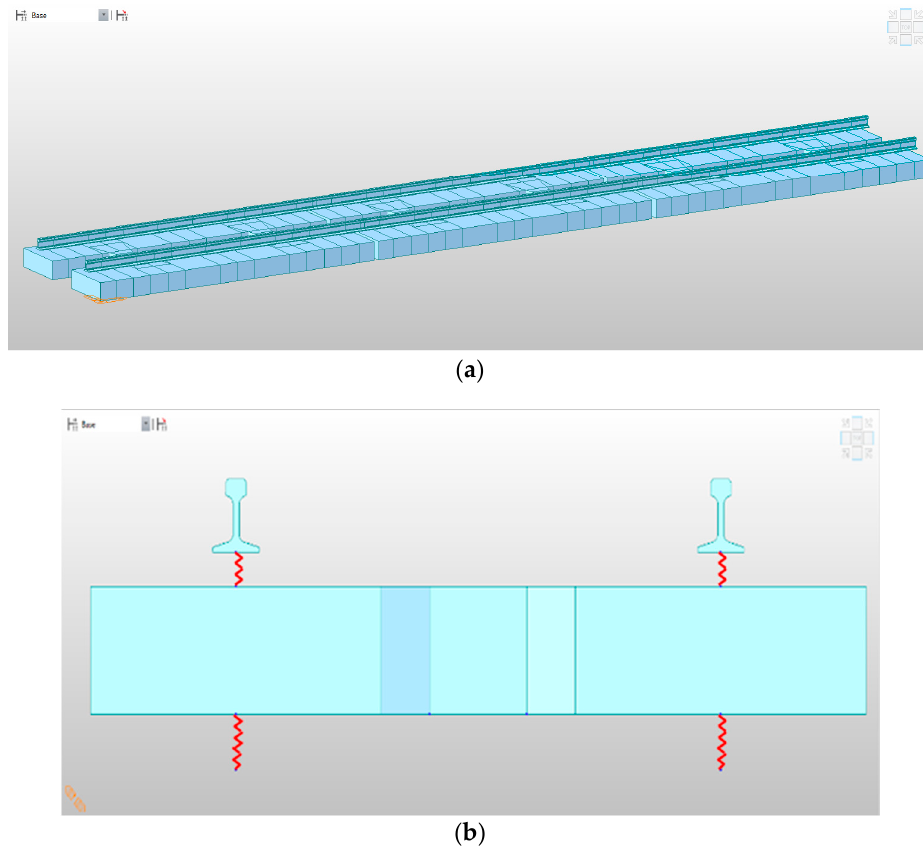
Figure 9. Modeling of the precast floating slab; ( a ) overview, and ( b ) front view. Table 3. Specification of track system.